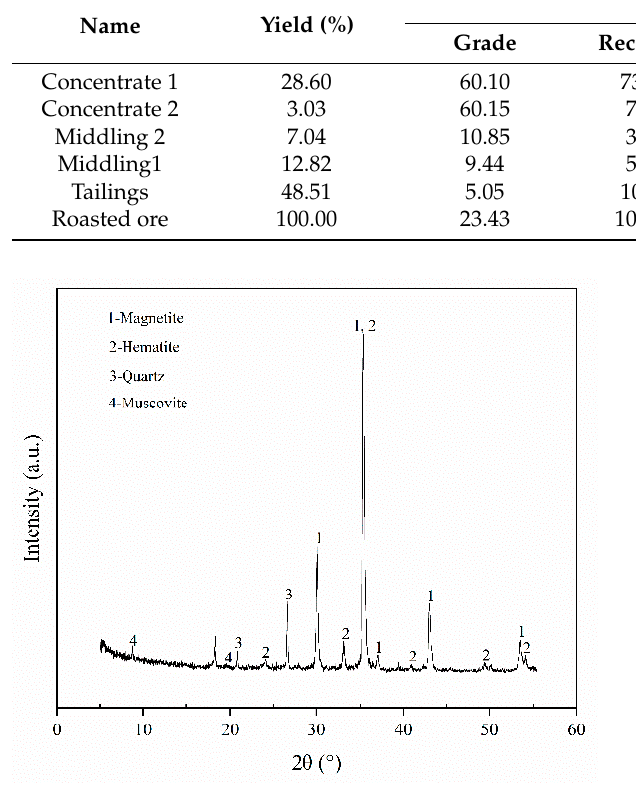
Figure 9. The XRD results of the mixed iron concentrate.